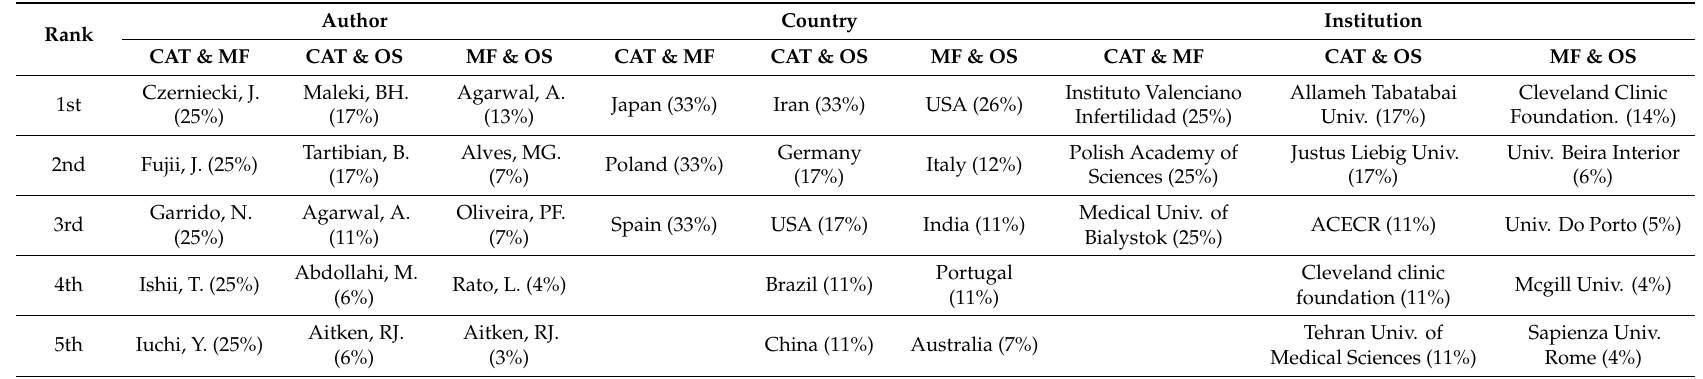
Table 4. Summary of the authors, countries and institutions significantly contributing to this field of knowledge according to the documents selected for the database created for this study. %: calculated over the total number of publications compiled from each combination of keywords (“MF & OS” = 91; “CAT & MF” = 3; “CAT & OS” = 15). Univ. =